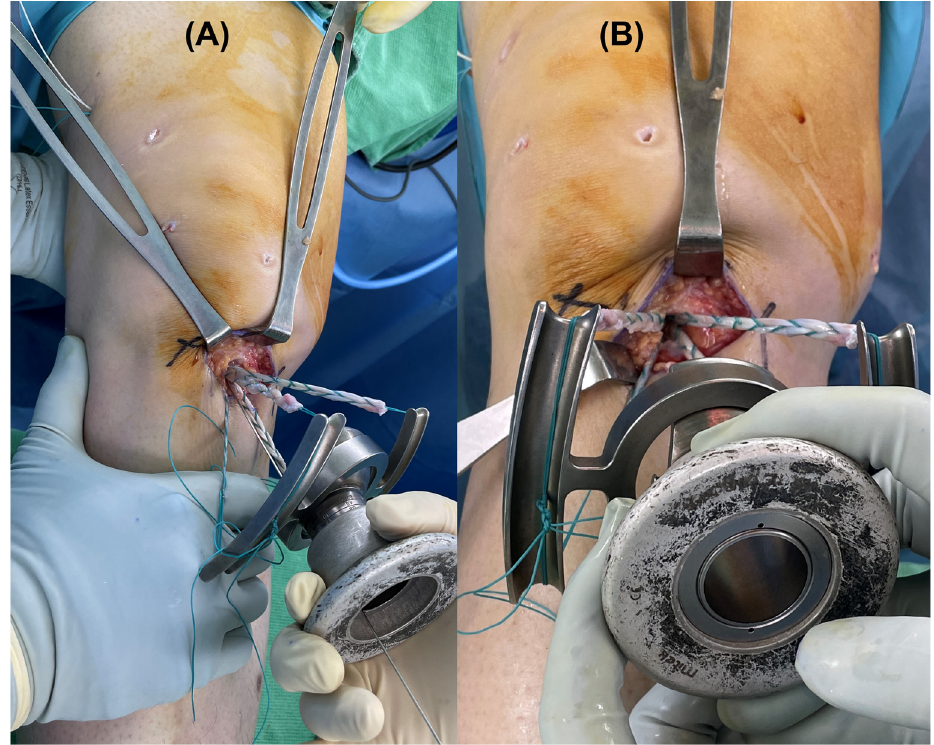
Figure 4. Intraoperative view of ( A ) a posterior draw force applied and ( B ) a posterior draw force not applied during anterior cruciate ligament